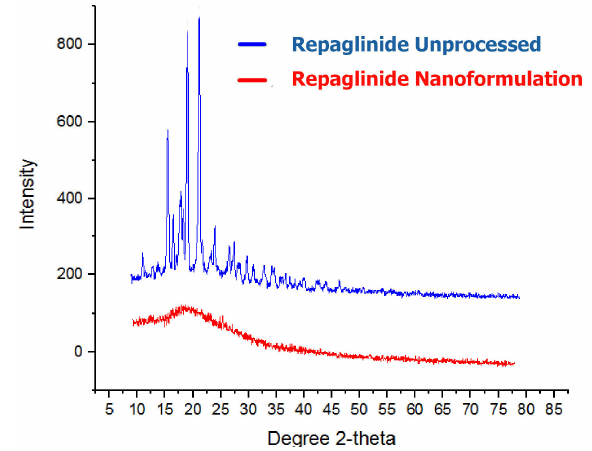
Figure 4. PXRD peaks of unprocessed Rp and Rp ‐ Nc.